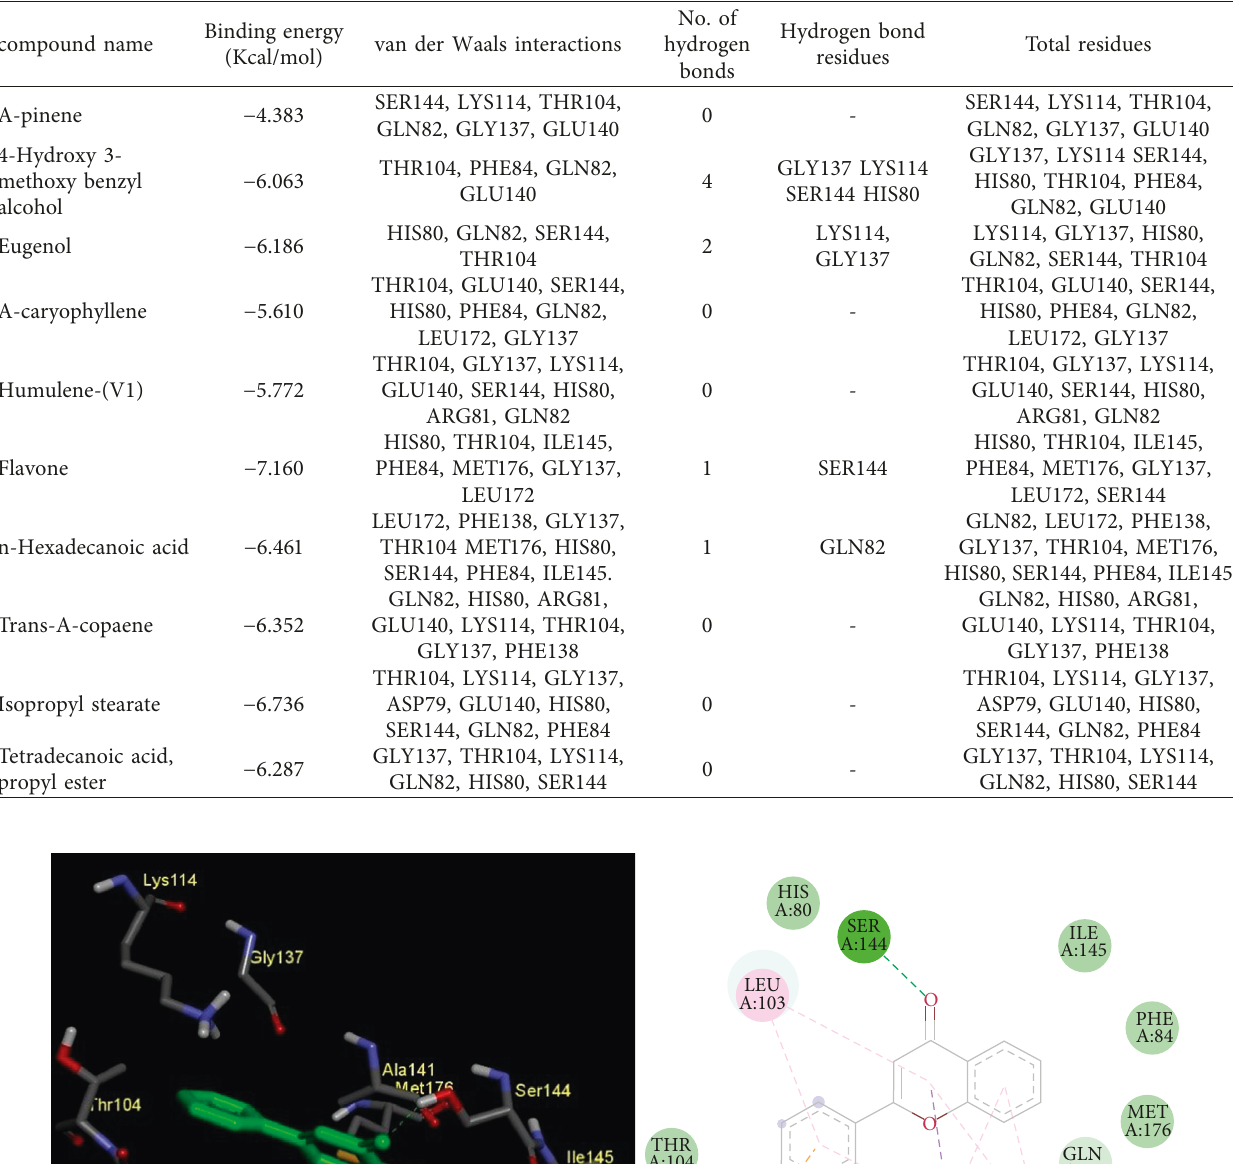
Table 4: Docked conformation of bioactive compounds against the lipase of Malassezia restricta.